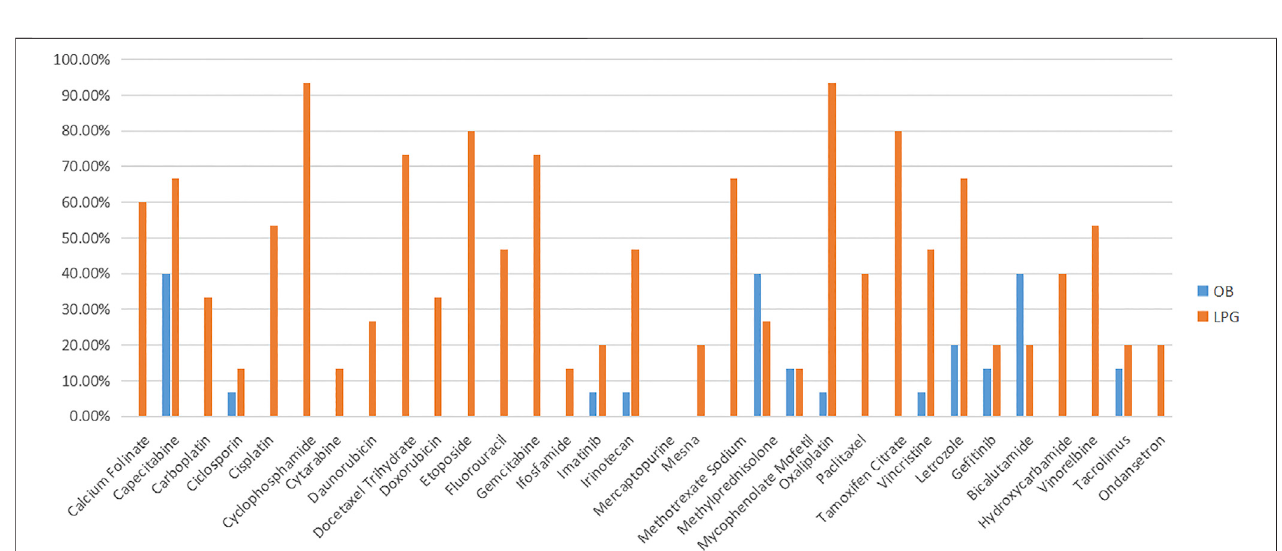
FIGURE 2 | The availability of LPG and OB medicines in secondary hospital.